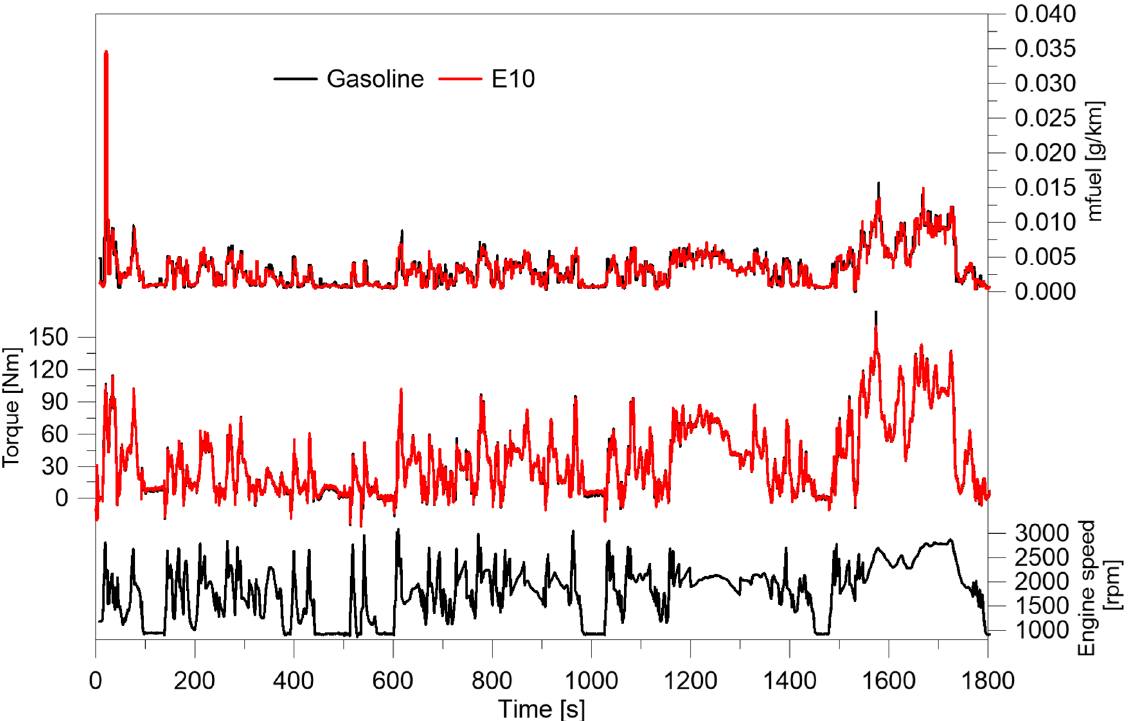
Figure 3. Instantaneous fuel consumption, torque and engine speed over the WLTC for gasoline and